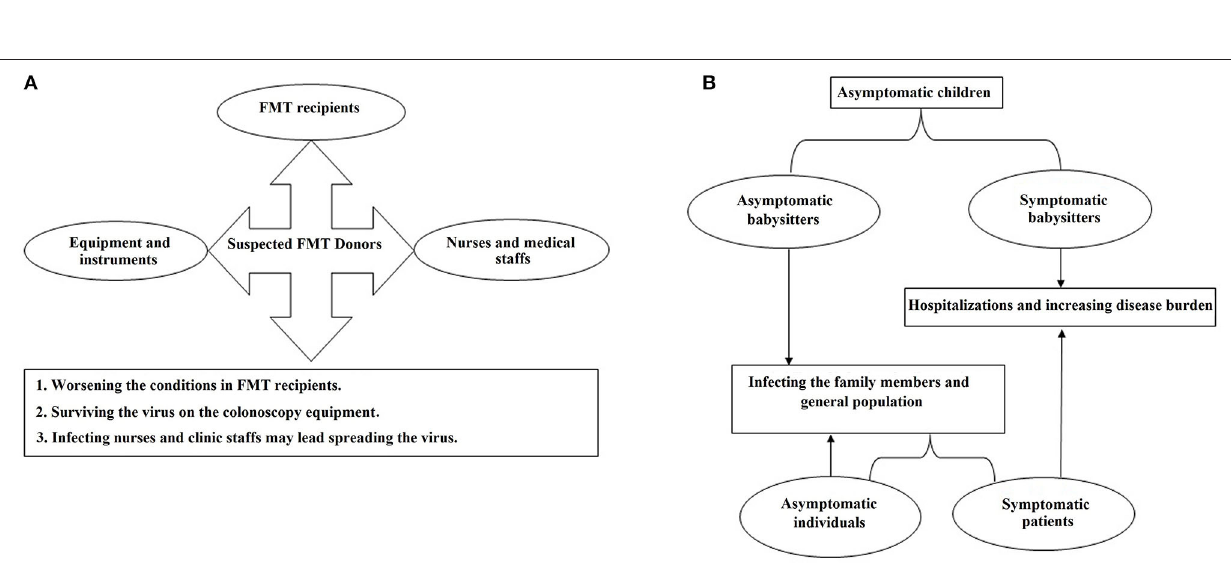
Frontiers in Public Health | www.frontiersin.org